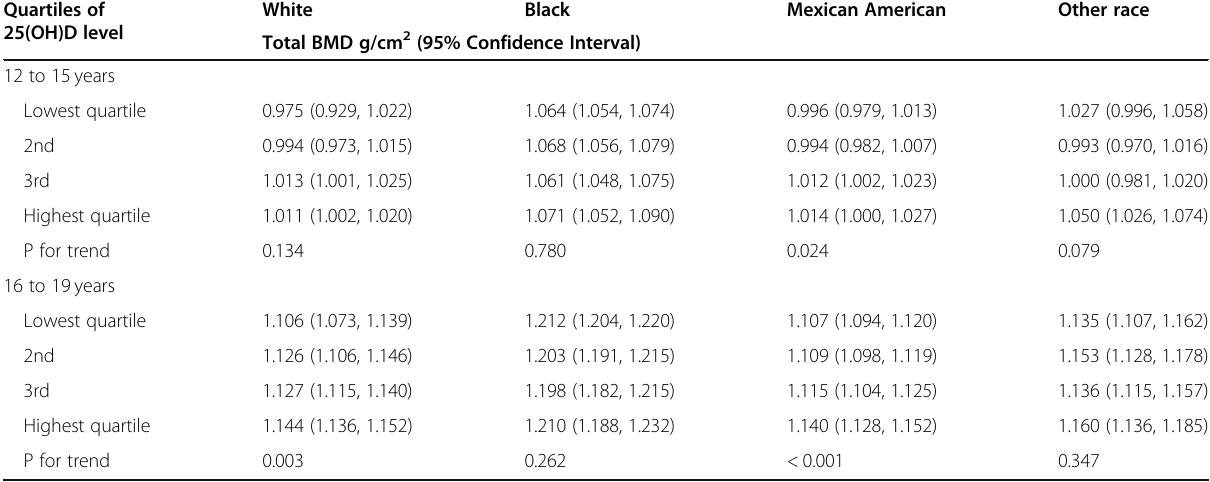
Table 5 Total bone mineral density by quartiles of serum 25(OH)D level, stratified by race/ethnicity and age Quartiles of 25(OH)D level